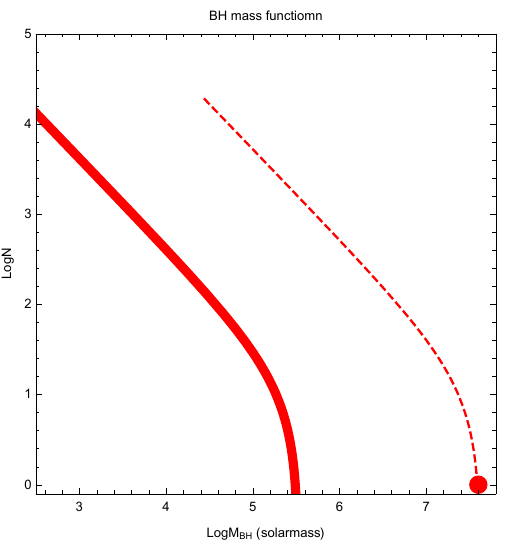
Figure 4. The mass distribution functions of BH within a single galaxy. The broken line shows the case for a s = 10 − 29 m, while the solid line and the separate point show for a s = 10 − 30.4 m. The latter case represents a more realistic estimate for the SMBH formation considering the coalescence at the central region by the dynamical friction within the time scale t d = 6.8 × 10 7